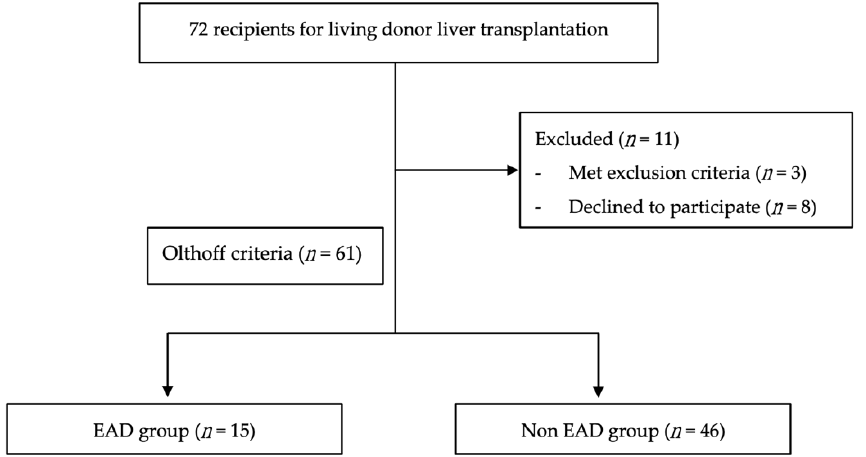
Figure 1. Flow diagram of patient selection and allocation. EAD, early allograft dysfunction.